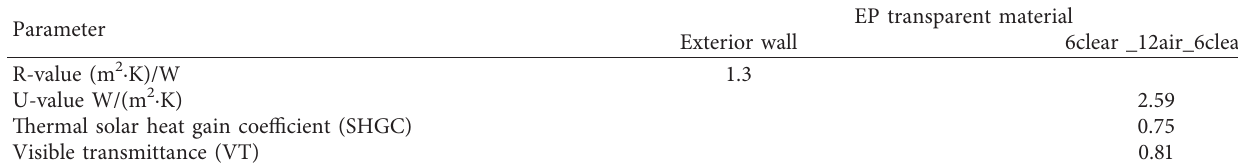
Figure 4: Location map of Southern Breeding Technology Service Center. (a) Overall location map of the project and (b) functional layout of the 7th floor of the project. Table 4: Material information of EP construction from wall and glass.